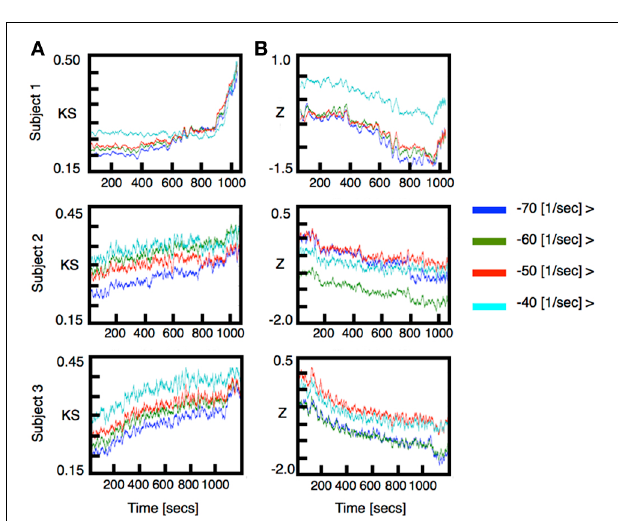
condition (blue). In both cases we plot count number on the scale (0.46000) (A) and (0.120000) for (B) . (C) Similarly to Figure 3B , we computed the superposition of histograms in a smaller frequency range for better visualization. The histograms were done with logarithmic binning and the frequency axis is logarithmic (base 2). The rainbow indicates a shift toward more damped states. The organization of stability undergoes non-trivial changes in low frequency bands (4–128 Hz).